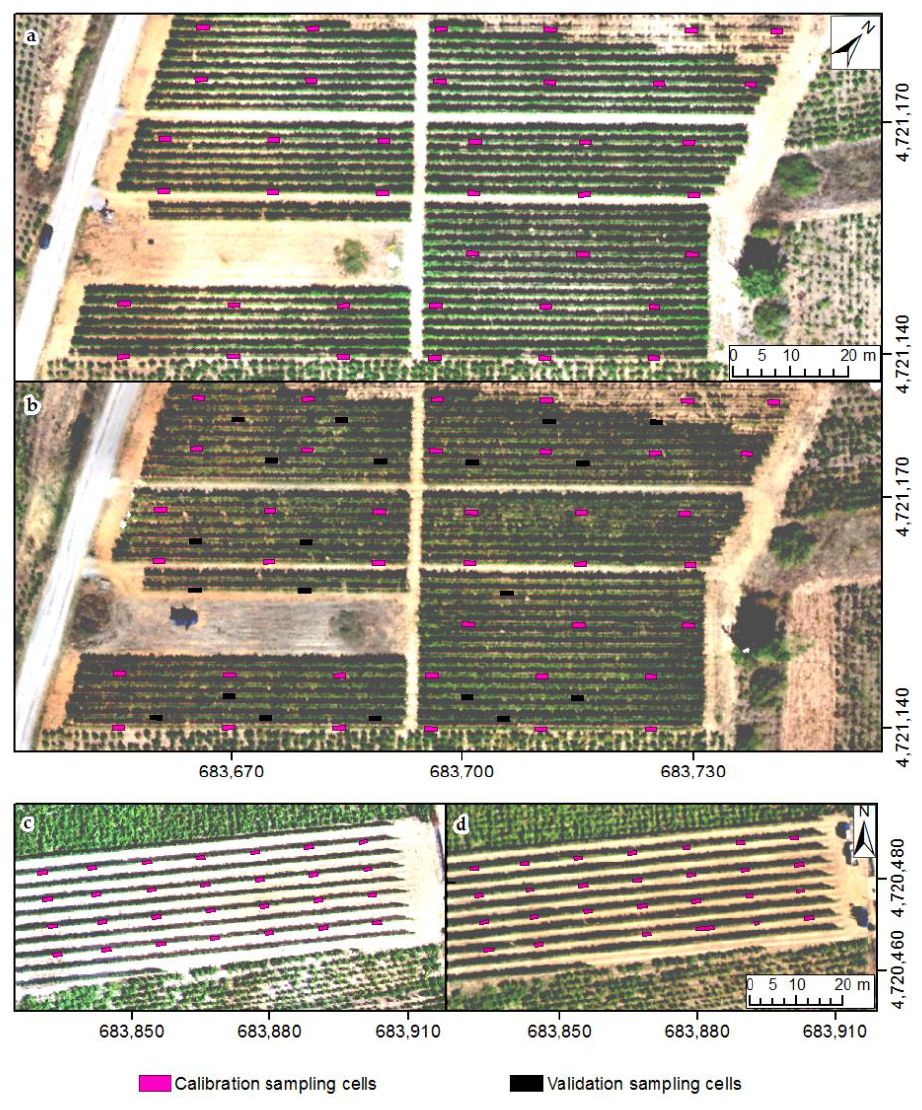
Figure 2. Sampling cell arrangement in the vineyards studied: ( a ), Menc í a 2019; ( b ), Menc í a 2020; ( c ), Godello 2019; ( d ), Godello 2020 (background images orthorectified for each vineyard and